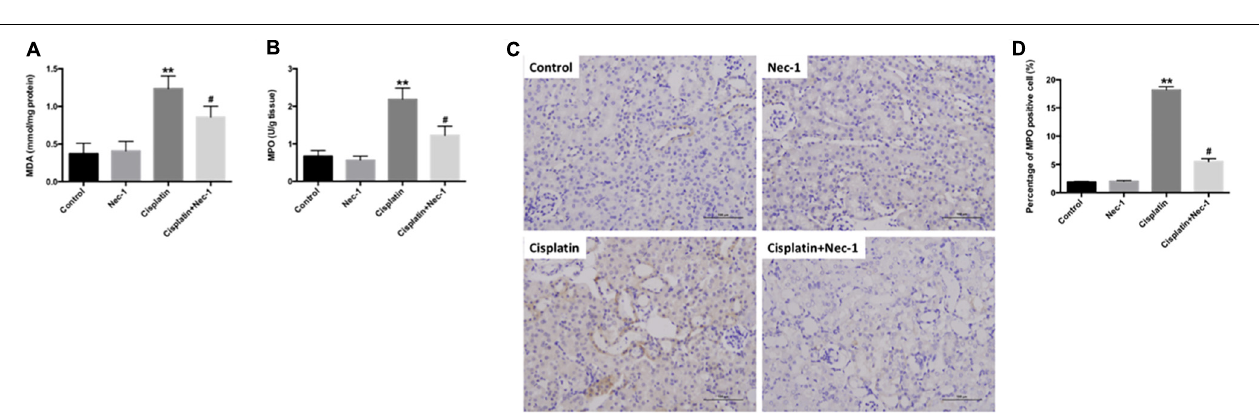
FIGURE 4 | Nec-1 attenuates oxidative stress in cisplatin-induced nephrotoxicity. (A,B) The oxidative stress parameters MDA content and MPO activity at 72 h after cisplatin administration in the kidneys were significantly increased ( ∗∗ p < 0.01 versus control group). Nec-1 reduced the upregulation of MDA and MPO levels (# p < 0.05 versus cisplatin group). (C,D) IHC staining of MPO in kidneys showed the similar trend among the four groups ( ∗∗ p < 0.01 versus control group, # p < 0.05 versus cisplatin